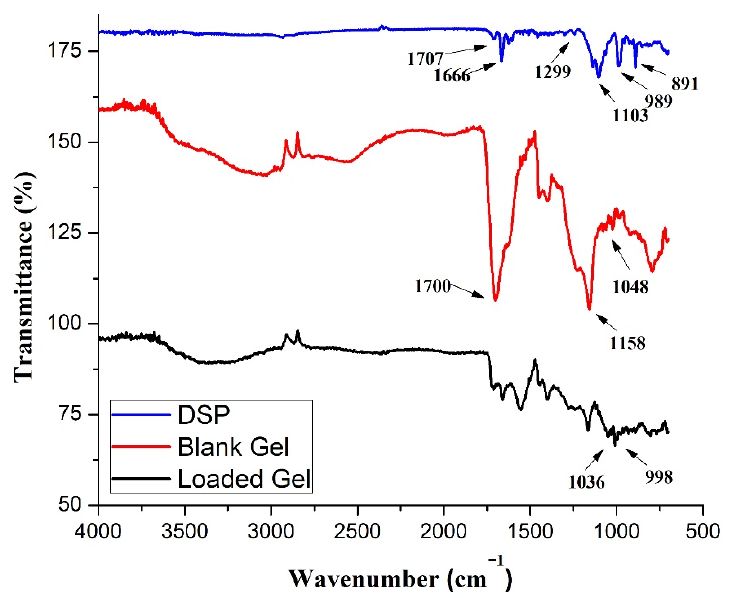
Figure 5. FTIR spectrums of DSP, blank, and drug-loaded semi-IPN hydrogels (AP-8). Blank refers to AP-8 semi-IPN hydrogels without DSP.